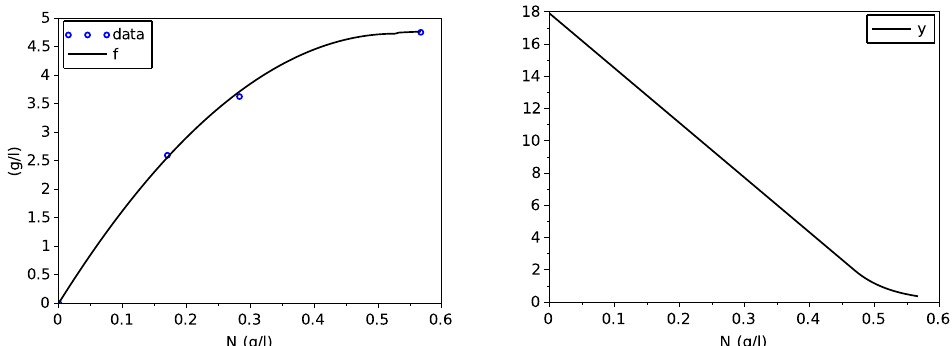
Figure 13. Results of the fitting of the function f on the experimental data ( left ) and of the corre- sponding variable yield function y ( right ).